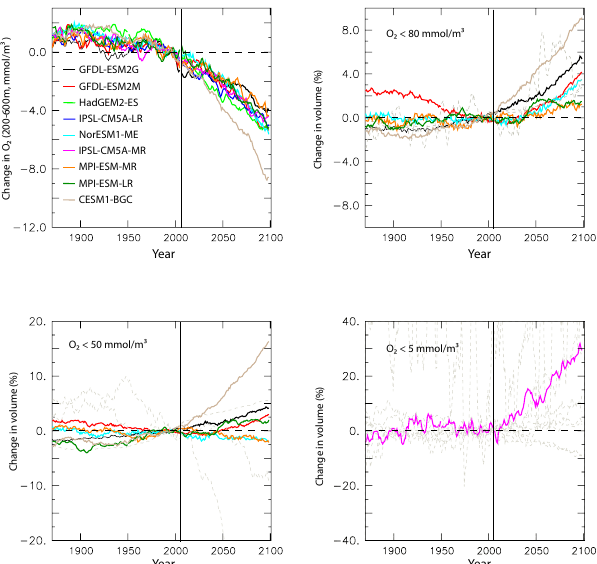
Fig. 10. Individual model time series for RCP8.5 and for of all models of (a) subsurface dissolved O 2 concentration changes be- tween 200 and 600m (mmolm − 3 ) , changes in (relative unit) vol- ume with (b) O 2 <80mmolm − 3 , (c) O 2 <50mmolm − 3 , and (d) O 2 <5mmolm − 3 (as in Cocco et al., 2013). Only models that simu- late volumes “close” ( ∗ ) to the ones estimated with WOA-corrected oxygen climatology (Bianchi et al., 2012) are colored. ∗ in between + 100 and − 50% of the data-based estimated